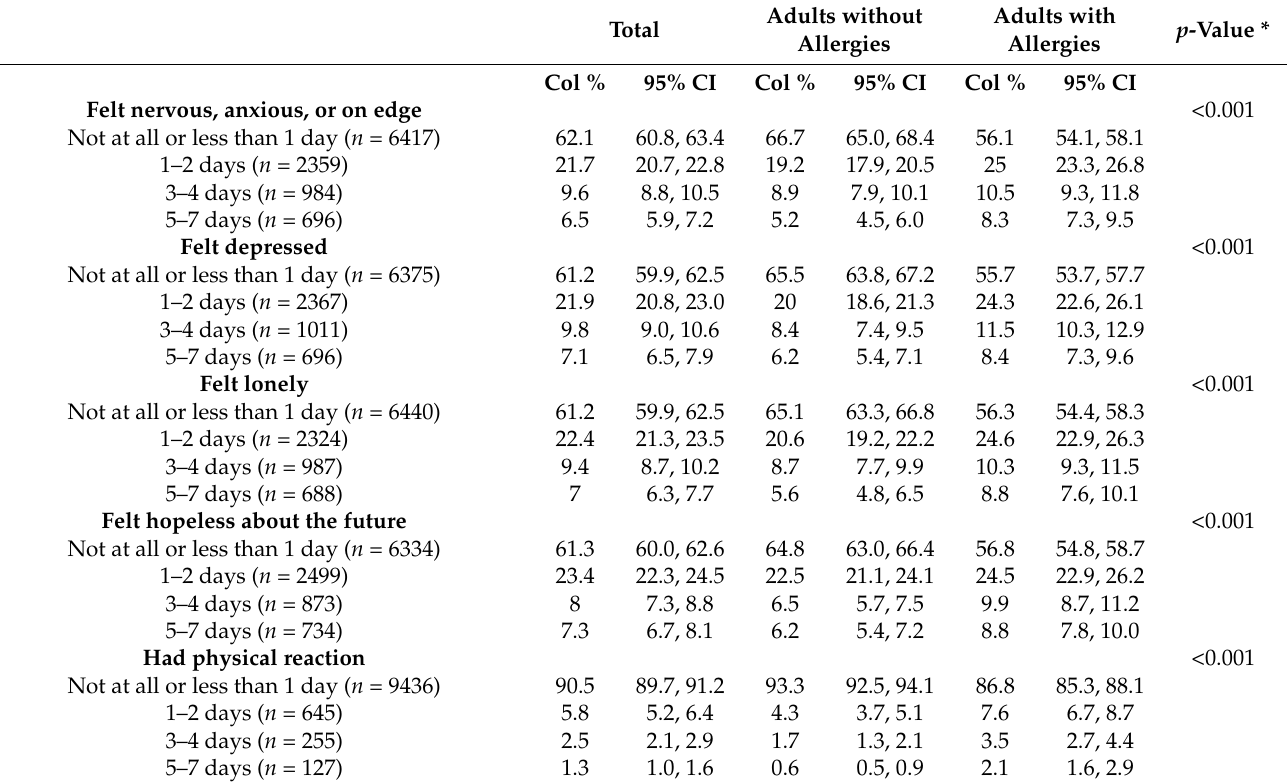
Models adjusted for: Age, gender, race, insurance status, asthma, and obesity. Table 4. Report of COVID-19 mental health symptoms in the past 7 days among COVID Impact Survey respondents ( n = 10, 760), stratified by allergy diagnosis (April–June